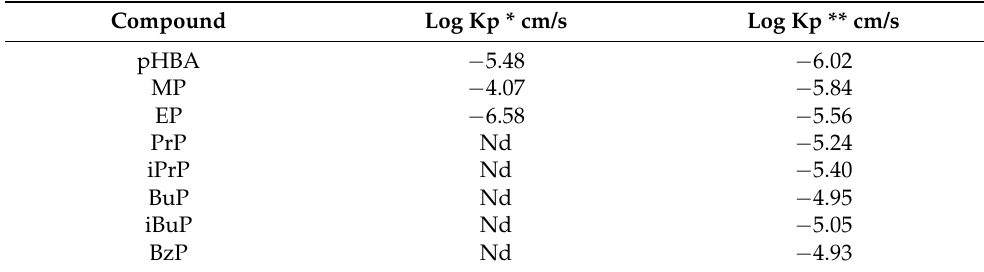
Table 4. Logarithm of experimental and calculated permeability coefficient (Kp). Log Kp * = Determined in the present study; Log Kp ** = SwissADME